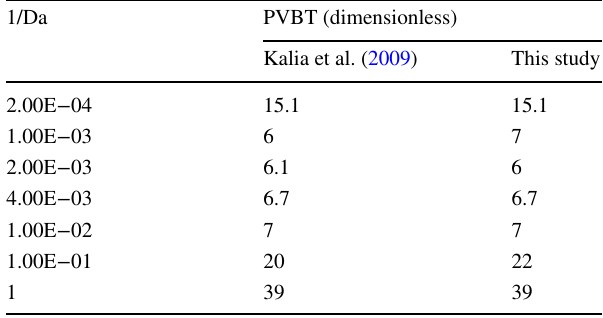
Fig. 3 Comparison of the current model result with result of Kalia et al. (2009) Table 1 Comparison of the results of this study and Kalia et